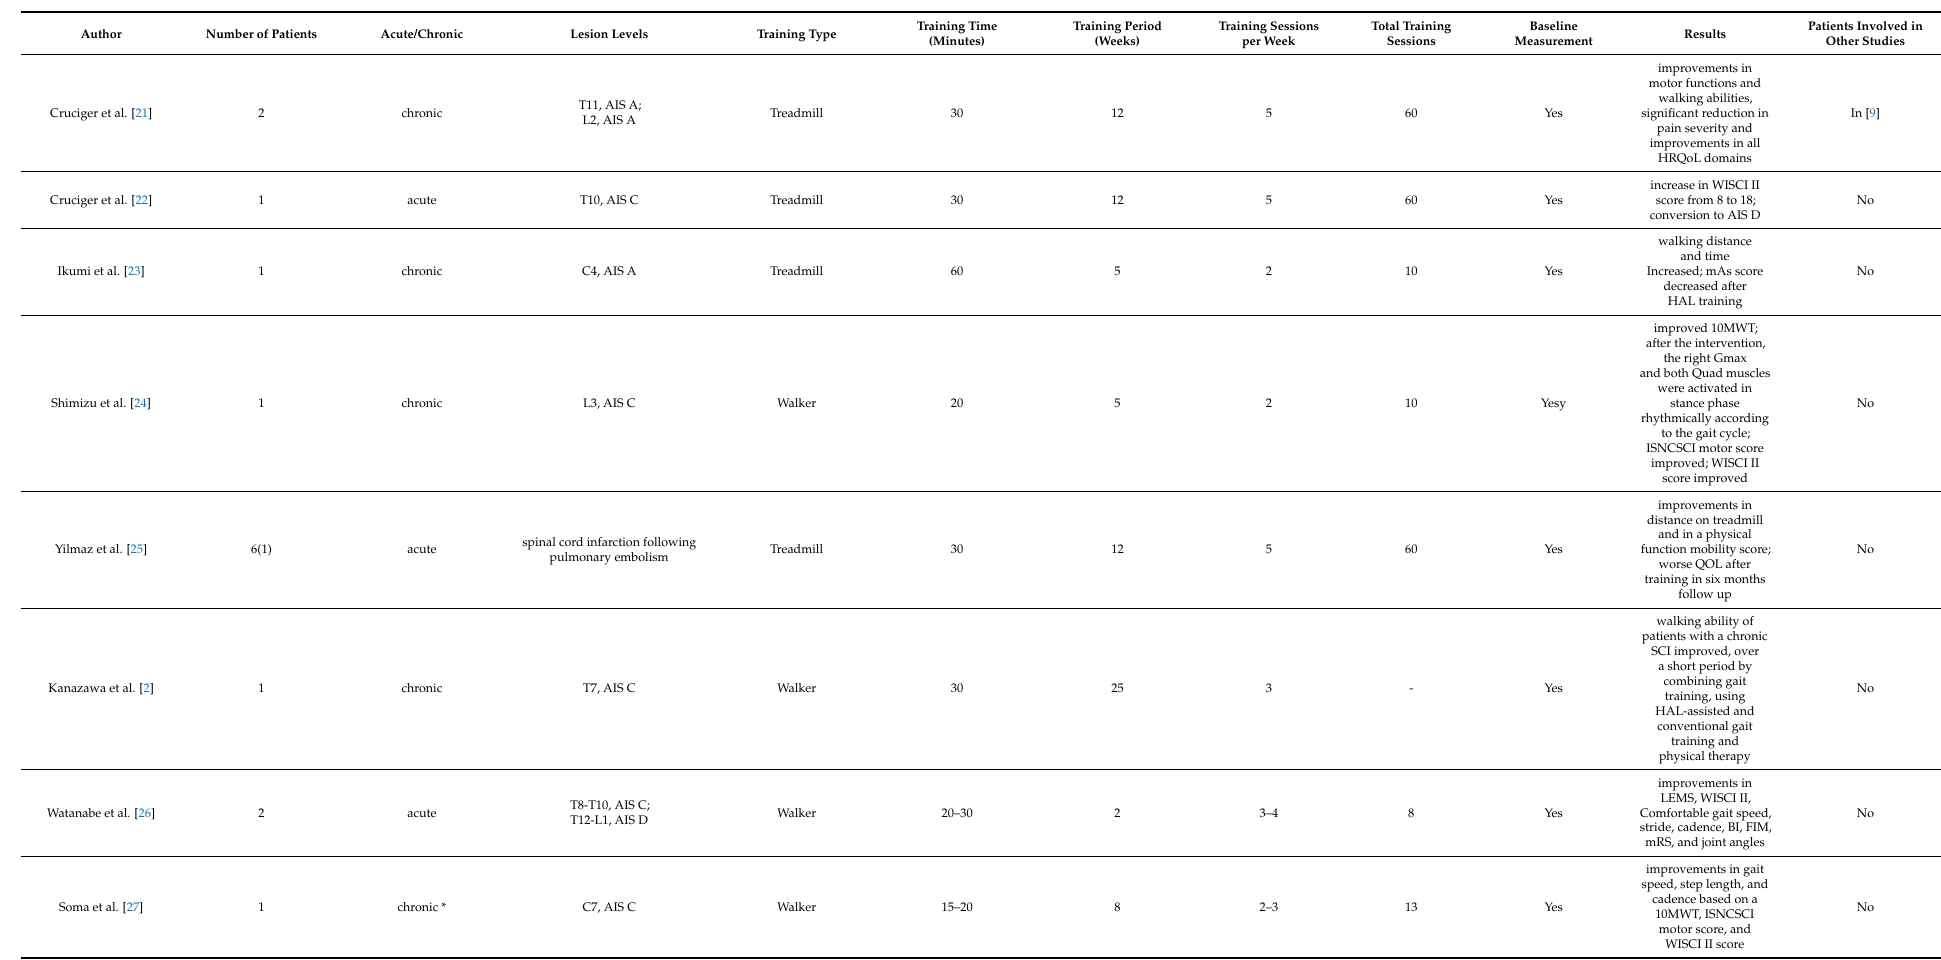
Table 2. Spinal cord injury single-case or two-case reports studies